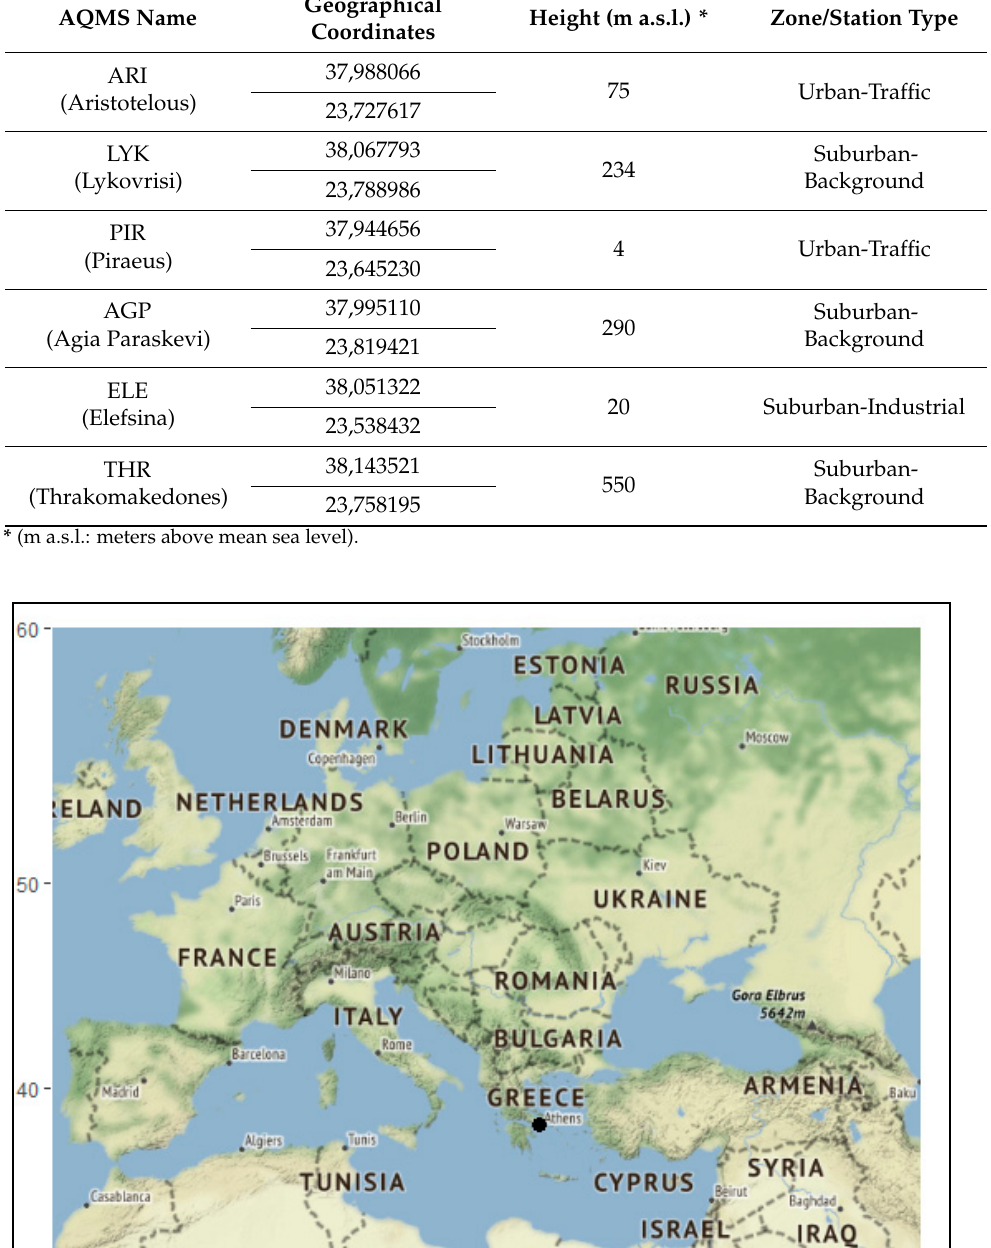
Table 1. List of the air quality monitoring stations (AQMS) along with their geographical coordi ‐ nates.